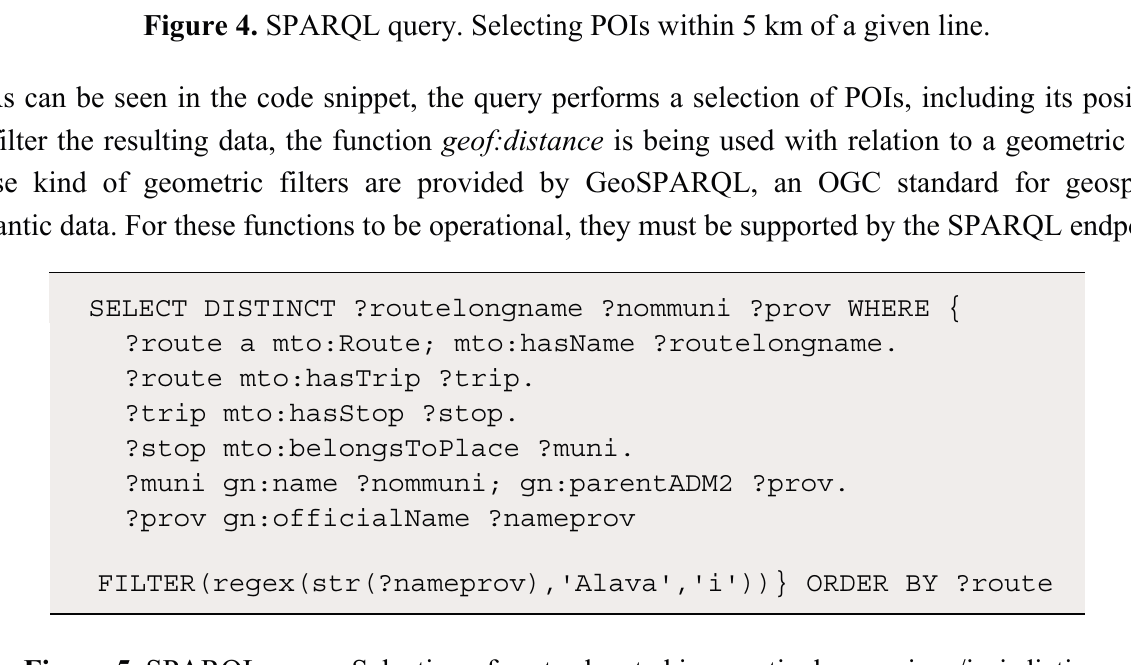
Figure 5. SPARQL query. Selection of routes located in a particular